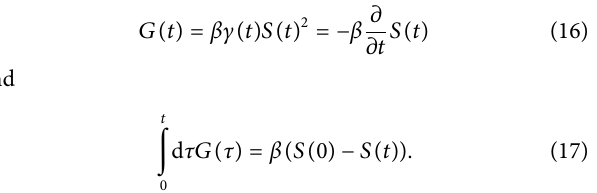
Frontiers in Chemistry |